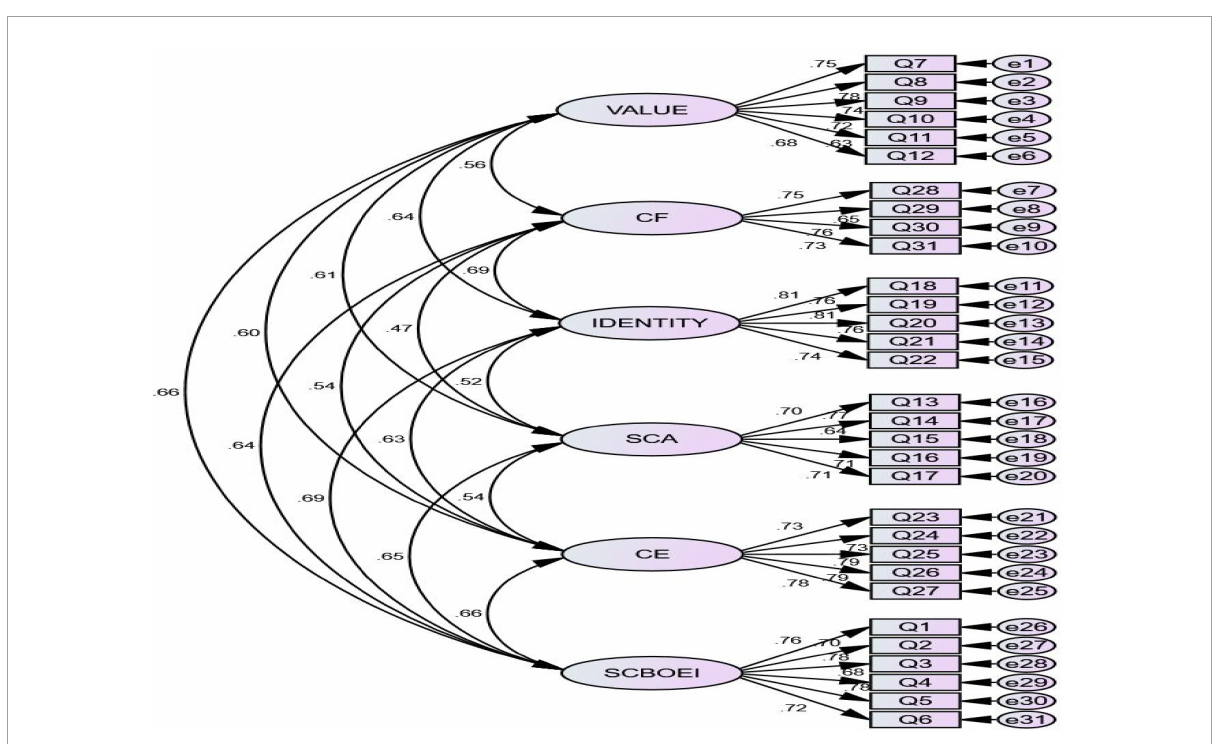
FIGURE1 Confirmation factor analysis diagram.